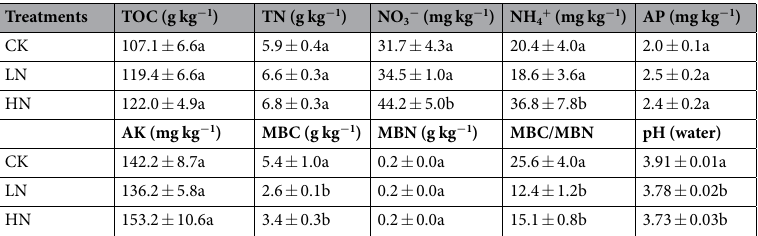
Table 2. Results of repeated measures ANOVA of soil nutrient availability, microbial properties and pH (Mean ± 1 SE, n = 3). The soil samples were taken from the organic top layer (about 0–10 cm). Different letters indicate significant differences among different treatments (Repeated measures ANOVA with Fisher’s LSD test, α =